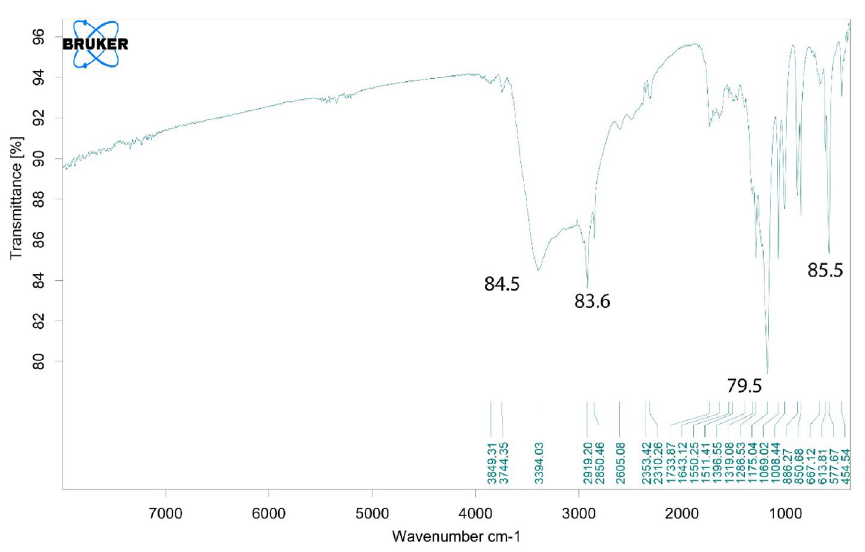
Figure 3. FTIR spectrum, related to bee